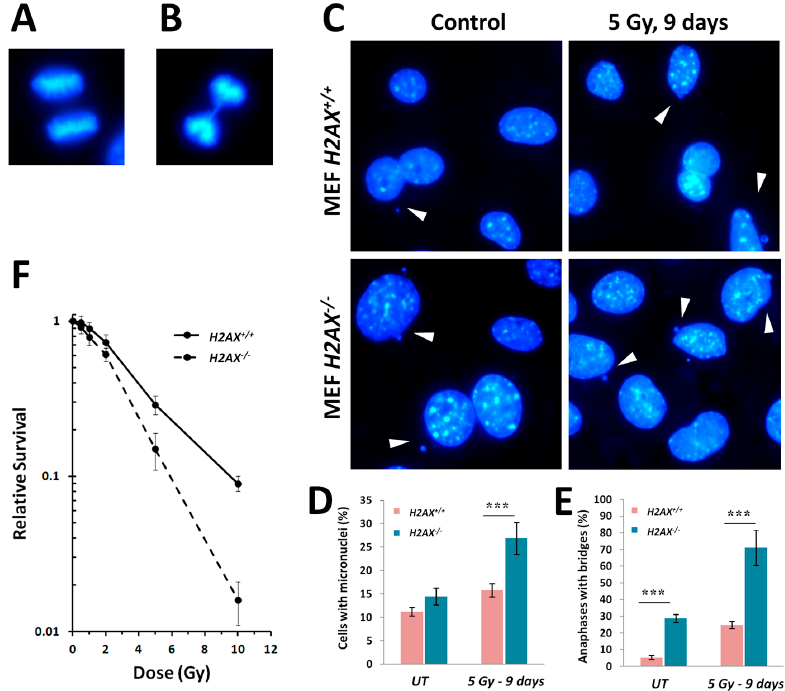
Figure 5. Increased genomic instability and radiosensitivity in MEF H2AX − / − cells. Microscopic images taken using a 100× objective of a representative normal anaphase ( A ) and an anaphase bridge ( B ), the latter being an event associated with genomic instability. Cells were grown on coverslips, fixed in paraformaldehyde and stained with DAPI as described in Experimental Section; ( C ) Representative microphotographs (100× objective) of MEF H2AX + / + and H2AX − / − cells either sham- or 5 Gy γ -irradiated and maintained for 9 days after irradiation showing incidence of micronuclei (white arrows). Cells were fixed on coverslips and processed for DAPI staining as above; ( D ) Bar graph showing quantification of the rate of anaphase bridges in H2AX − / − compared to H2AX + / + untreated or 5 Gy irradiated MEFs. Cells were processed as above and anaphase bridges were scored ( n = 200 anaphases per experiment); ( E ) Quantification of the rates of micronucleated H2AX − / − compared to H2AX + / + untreated or 5 Gy irradiated cells. Total of 1000 cells were scored per experiment. *** denotes statistically significant difference between H2AX − / − and H2AX + / + cells with p < 0.001 (Student’s t -test); ( F ) Clonogenic survival curves of H2AX + / + and H2AX − / − MEFs irradiated with 0, 0.5, 1, 2, 5 and 10 Gy and allowed to form surviving colonies as described in the Experimental Section. Data are plotted as a fraction of surviving cells relative to untreated control of the same genotype. Data represent the mean ± SD obtained from three independent experiments.